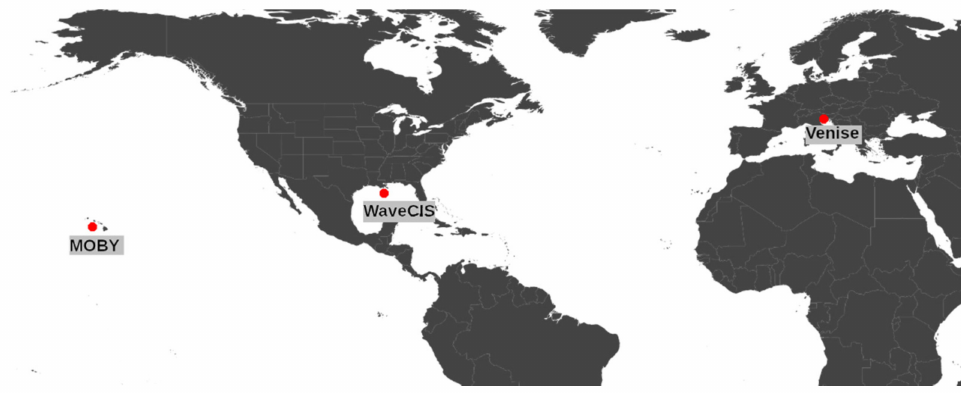
Figure 1. The locations of the three in situ stations. Venise and WaveCIS are AERONET-OC SeaPRISM sites, while MOBY is a moored